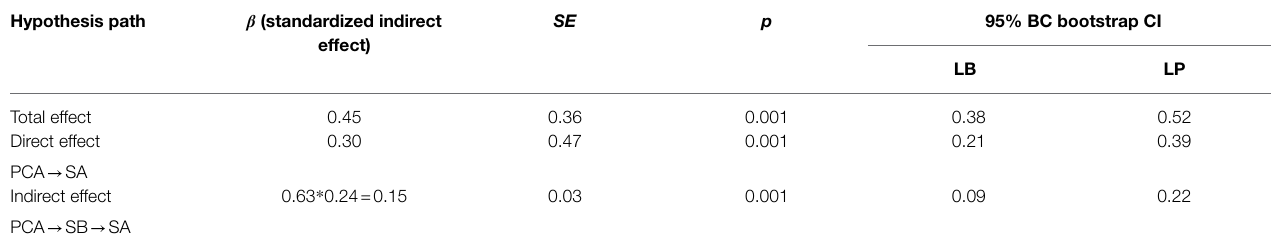
TABLE 4 | The mediating effect of school bonding on parent-child attachment and social adaptation. Hypothesis